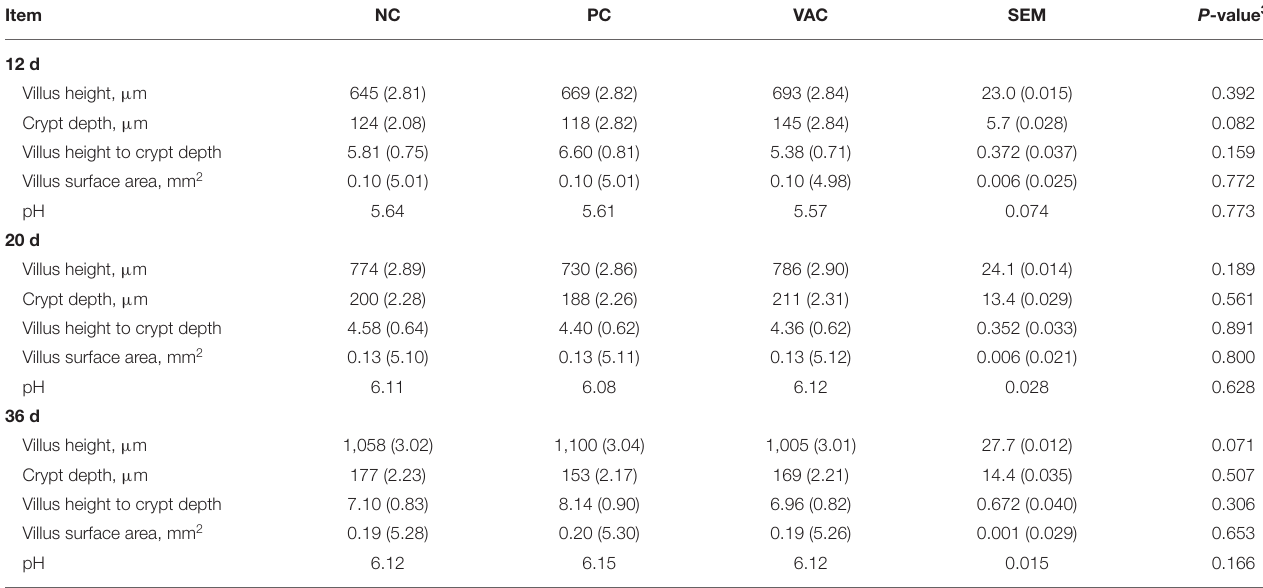
TABLE 5 | Effects of coccidiosis vaccination on jejunal morphology and duodenal pH of broilers in 36 d post-hatch 1,2 .